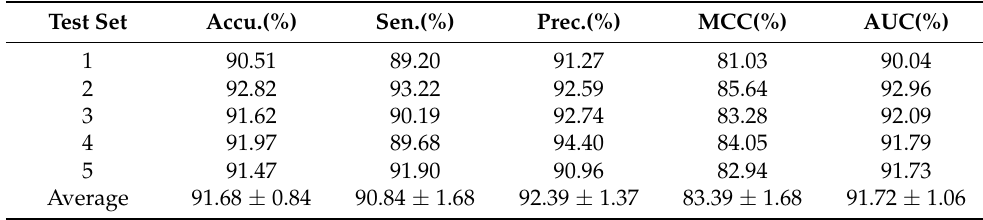
Table 1. 5FCV prediction results obtained by RoFDT on the Enzyme dataset.